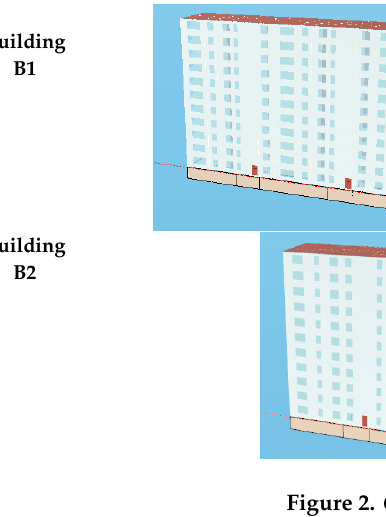
Table 4. General multi-family residential building